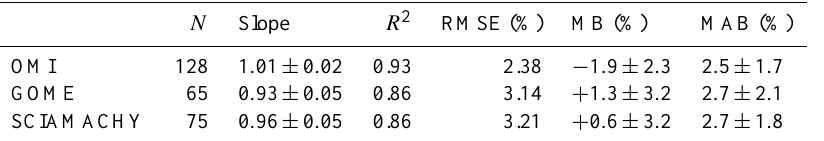
Table 2. Parameters obtained in the correlation analysis between satellite TOC data (OMI, GOME and SCIAMACHY) and Bentham mea- surements as gathered over Granada during the period between April 2005 and May 2006. The parameters are the following: the number of data ( N ), the slope of the regression, the correlation coefficients ( R 2 ) , the root mean square errors (RMSE), the mean bias (MB) and the mean absolute bias (MAB).